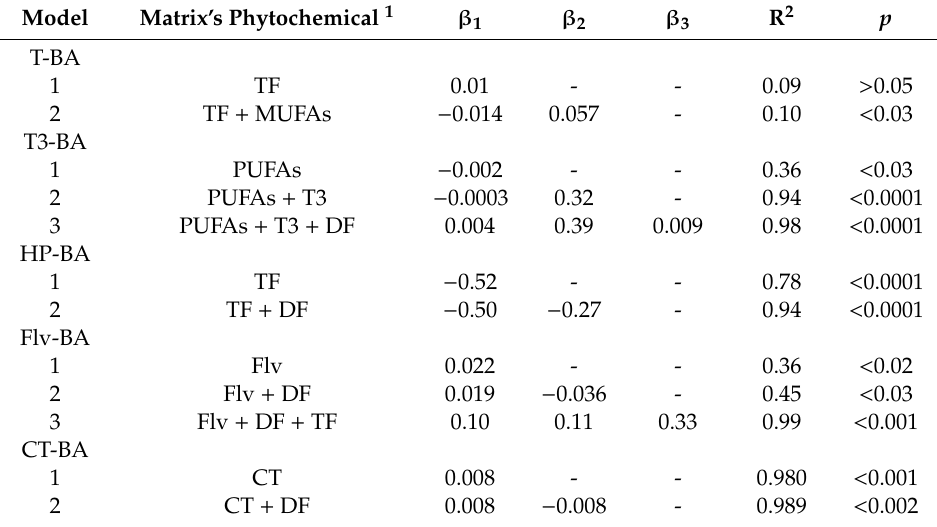
Table 3. Multivariate regression analysis of phytochemical in vitro bioaccessibility 1